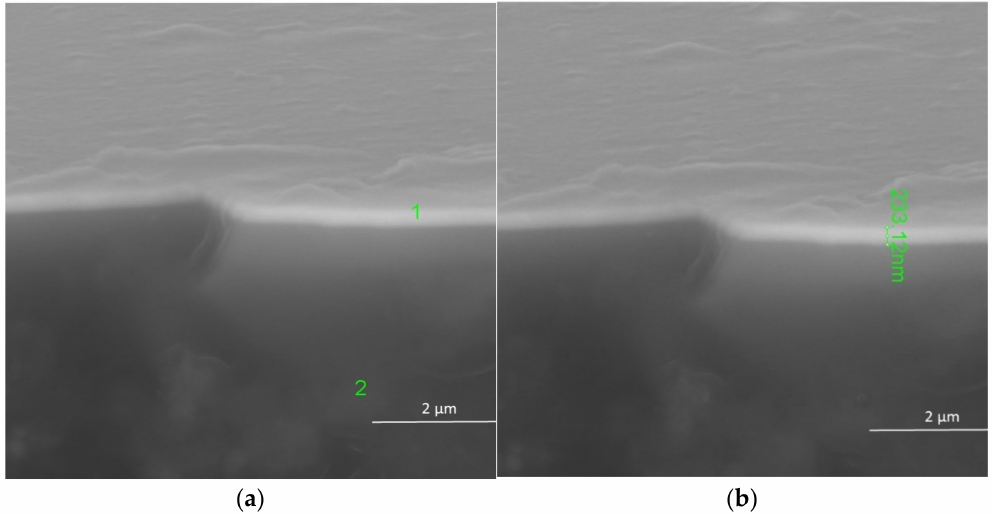
Figure 6. ZrO 2 -Gd 2 O 3 layer deposited at 700 ◦ C (its surface and cross-section) ( a ) and its thickness ( b ). Molar content of Gd(tmhd) 3 in the gas reaction mixture: 10%. Synthesis time was 30